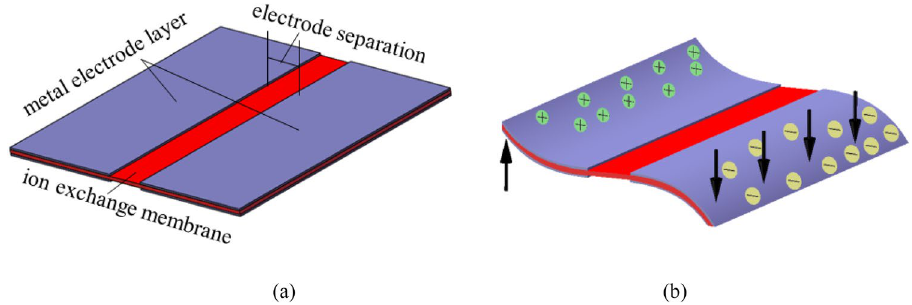
Figure 1. The twisting motion of IPMC with patterned electrode. ( a ) Before applying voltage. ( b ) After applying voltage.